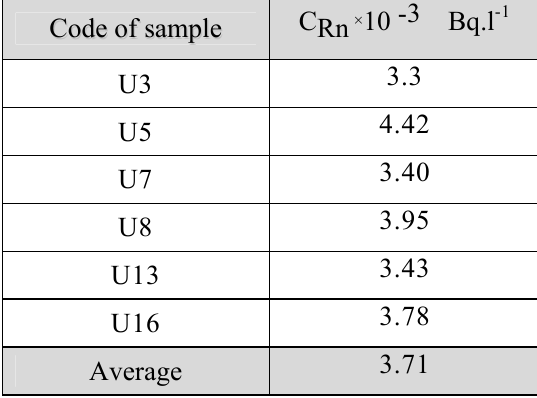
Table 6: Radon concentration in urine human of Basrah